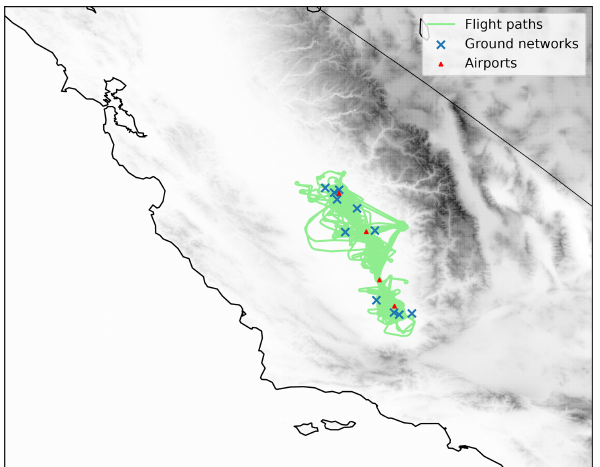
Figure 3. Flight paths of all aircraft deployments in this field cam- paign (green). Airports where low approaches were conducted (red triangles) and with ground ozone monitors (blue crosses) are